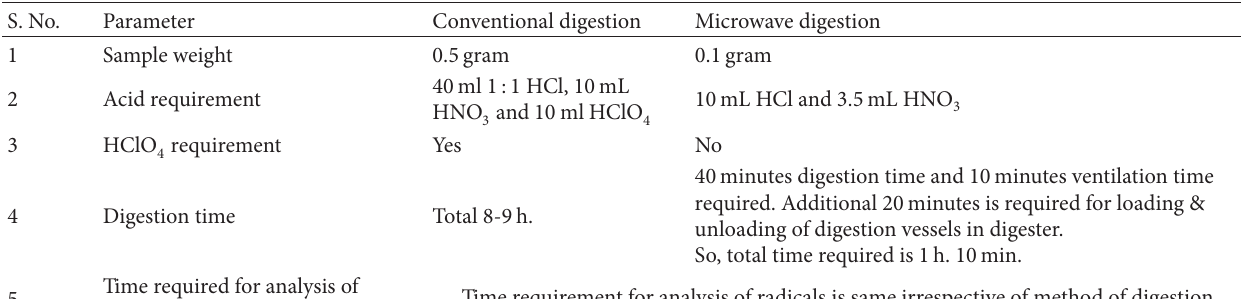
T 8: Conventional digestion versus developed microwave